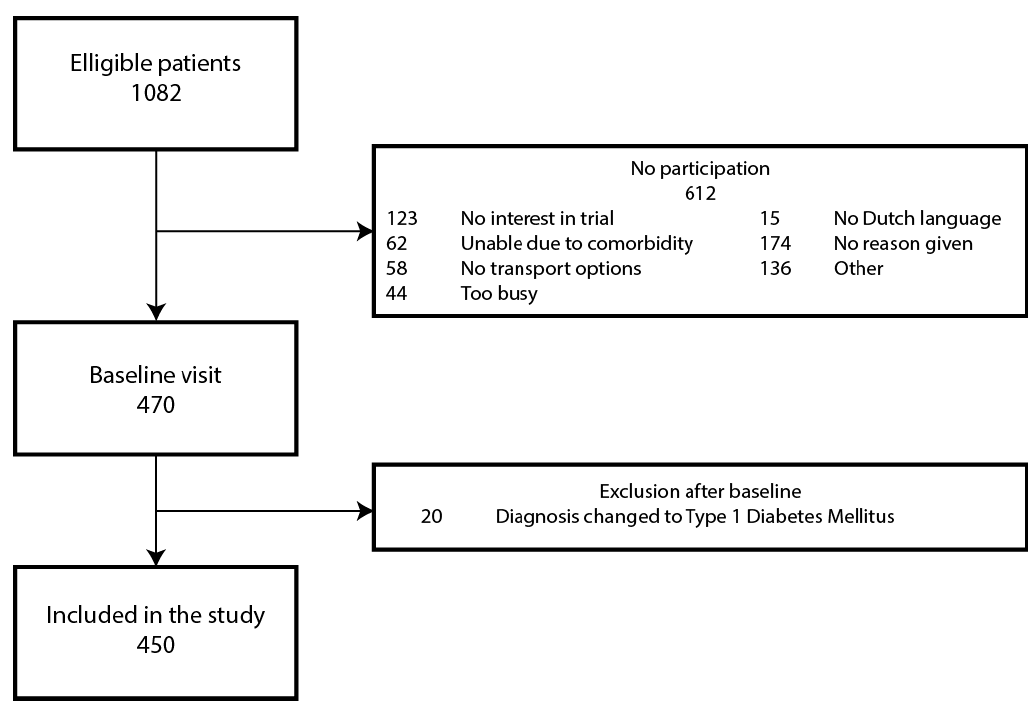
Figure 2. Patient recruitment flowchart.